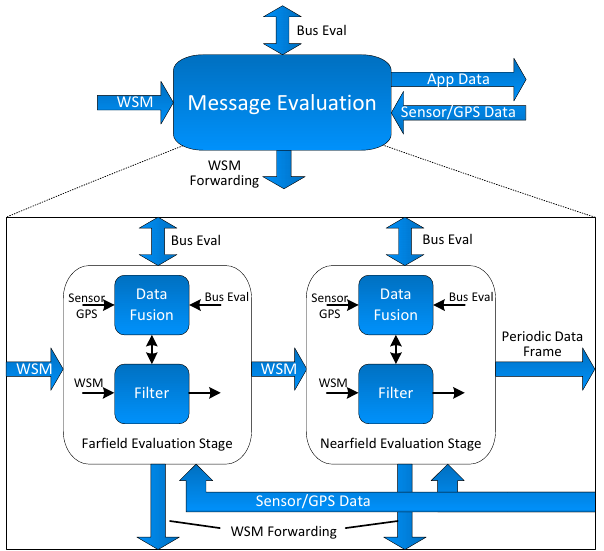
Refined Message Evaluation Building Block According to FFN and NFN Classification NFN. Therewith, an application specific cost function is to be defined for each application, which weights the data of each node in the NFN. Finally these frames are periodically sent over the internal E/E network via the E/E Architecture Interface to the required safety application like CACC, since they depend on information updated regularly [6].